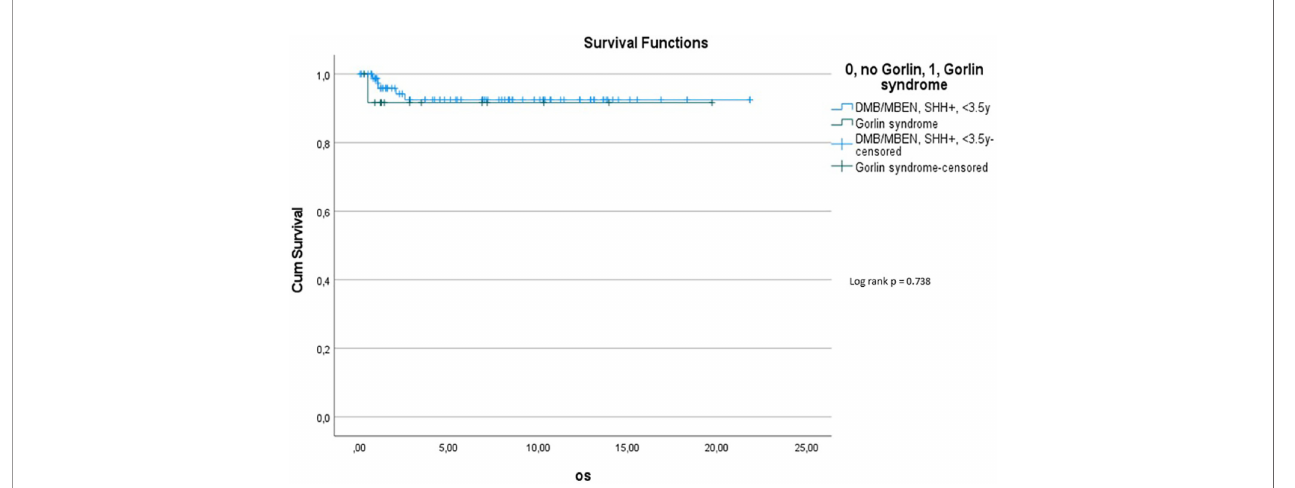
FIGURE 7.1 | OS for all SHH +, MBEN/DMB, <3.5 vs . all Gorlin patients.